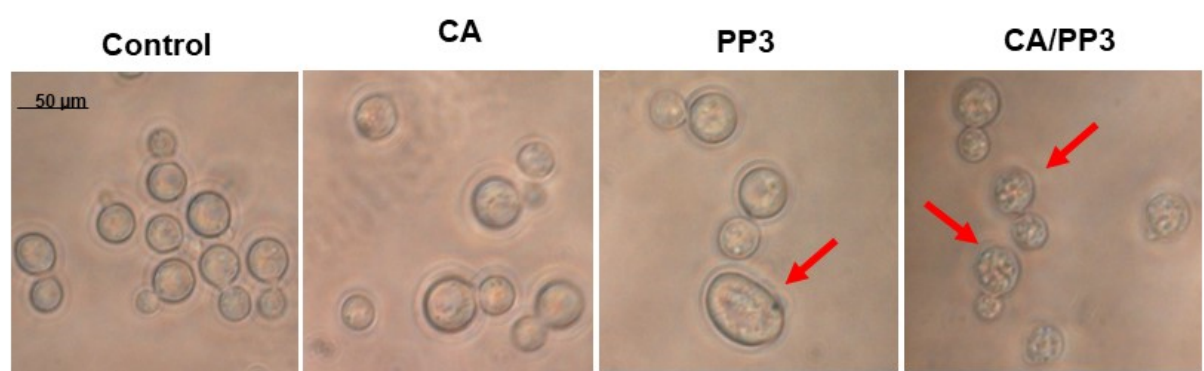
Figure 4. Morphological analysis of C. neoformans H99 yeast-like cells after treatment with separate additions of CA (50 µ g/mL), PP3 (200 µ g/mL) or a combination of both extracts. YPD-grown exponential cells (OD 600 = 0.9) were exposed for 5 h at 37 ◦ C to the indicated concentrations of CA and PP. An untreated sample was maintained as a control. Two similar representative images from each treatment were taken by means of Nomarski interferential contrast. The meaning of red arrows is explained in the text.